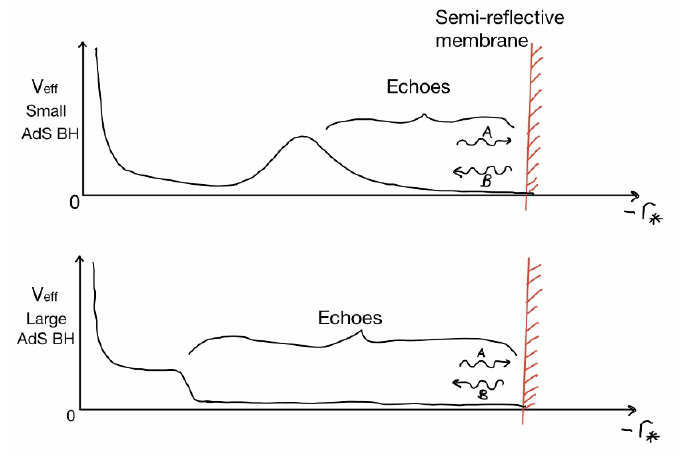
Figure 1 . Above is a depiction of how echoes are generated for very large ( r H =L (cid:29) 1) and very small ( r H =L (cid:28) 1) AdS black holes. The event horizon in these coordinates is at r (cid:3) = (cid:0)1 and the conformal boundary is at r (cid:3) = 0. The general solution to the massless scalar wave equation near the horizon takes the form (cid:24) Ae (cid:0) i! ( t + r (cid:3) ) + Be (cid:0) i! ( t (cid:0) r (cid:3) ) . The semi-re(cid:13)ective membrane, depicted by the vertical read line, allows for the partial re(cid:13)ection of scalar perturbations with a re(cid:13)ectivity of j ( B=A ) e 2 i!r (cid:3) j 2 . After the perturbation is partially re(cid:13)ected o(cid:11) the membrane it will head towards the conformal boundary and encounter the e(cid:11)ective potential causing re(cid:13)ection back towards the membrane. The process repeats until the perturbation dissipates. For very small black holes the e(cid:11)ective potential contains a local max before diverging near the boundary. This is in contrast to very large black holes whose e(cid:11)ective potential continues to increase. For asymptotically (cid:13)at black holes the local maximum is still present. However, there is no conformal boundary and the potential does not